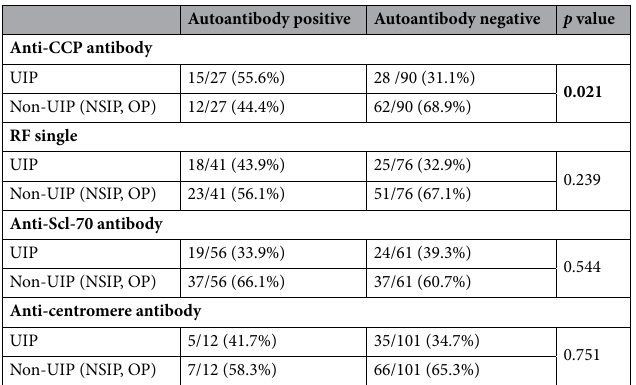
Table 4. Pattern of ILD in SSc patients based on the presence of autoantibodies. Bold text indicates statistical significance. Values are expressed as N (%). UIP, usual interstitial pneumonia; NSIP, non-specific interstitial pneumonia; OP, organizing pneumonia; SSc, systemic sclerosis; ILD, interstitial lung